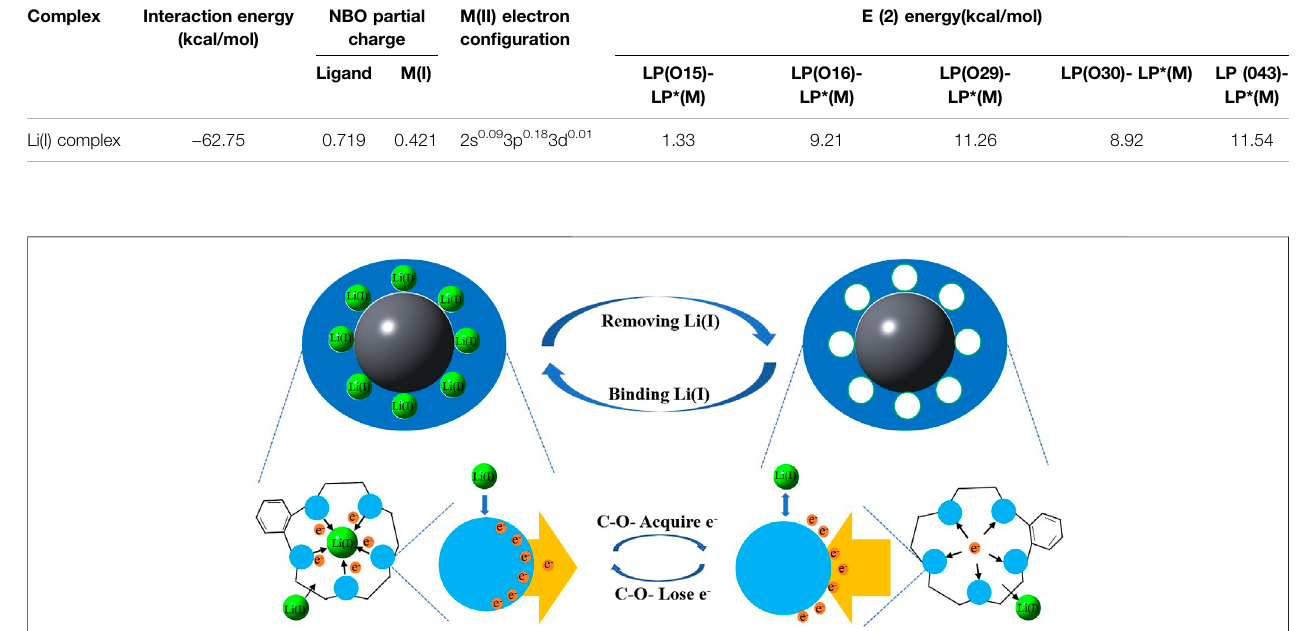
FIGURE 12 | Adsorption mechanism of PAN-CE@SiO 2 /zeolite for Li(I).